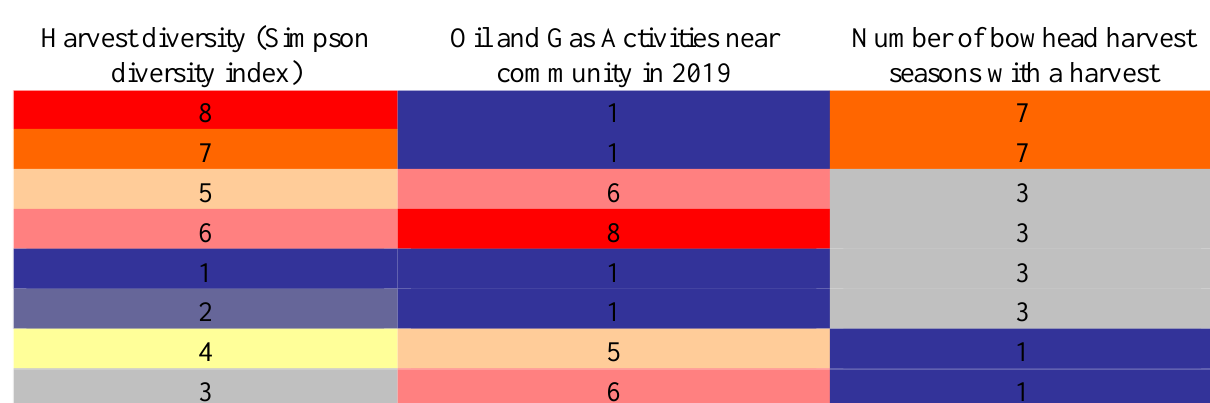
Table A2.4 Ecosystems –